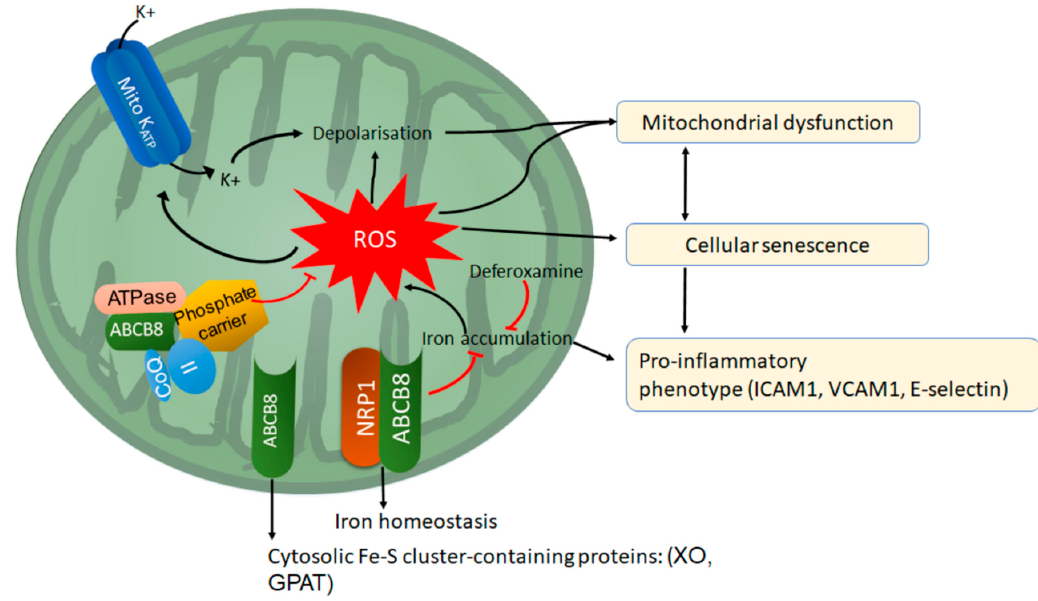
Figure 5. The NRP1-ABCB8 pathway: Schematic representation of the NRP1-ABCB8 pathway in regulating iron homeostasis, iron-dependent oxidative stress, mitochondrial function and cellular senescence.